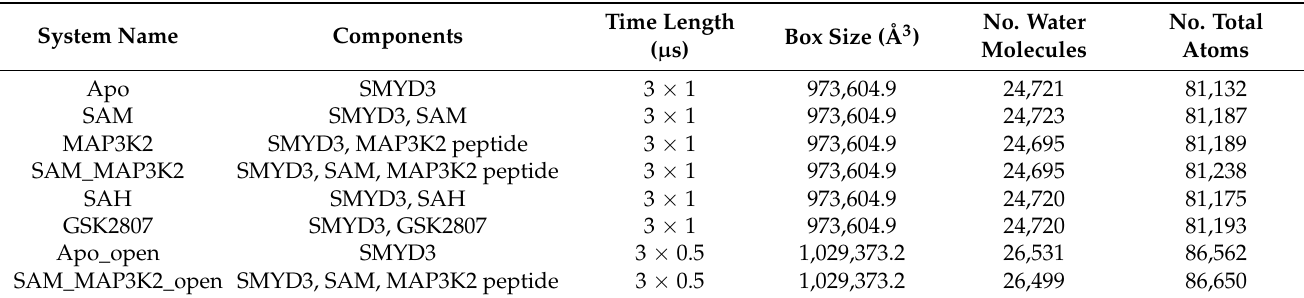
Table 1. Simulated models of SMYD3 with different